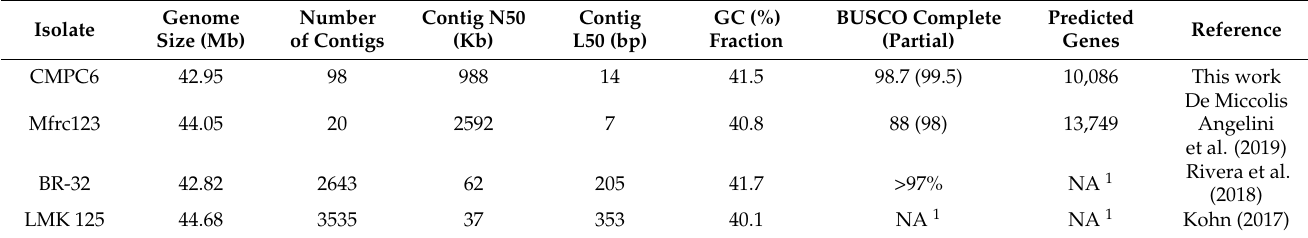
Table 1. Assembly features and gene prediction information of M. fructicola genomes.